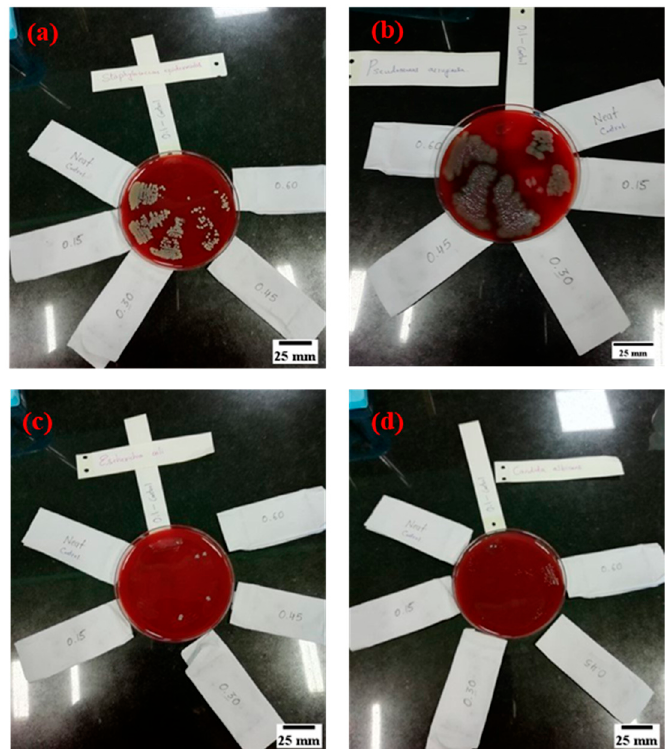
Figure 17. Test samples immersed in bacterial suspension with ( a ) Staphylococcus epidermidis ( b ) Pseudomonas aeruginosa ( c ) Escherichia coli ( d ) Candida albicans .